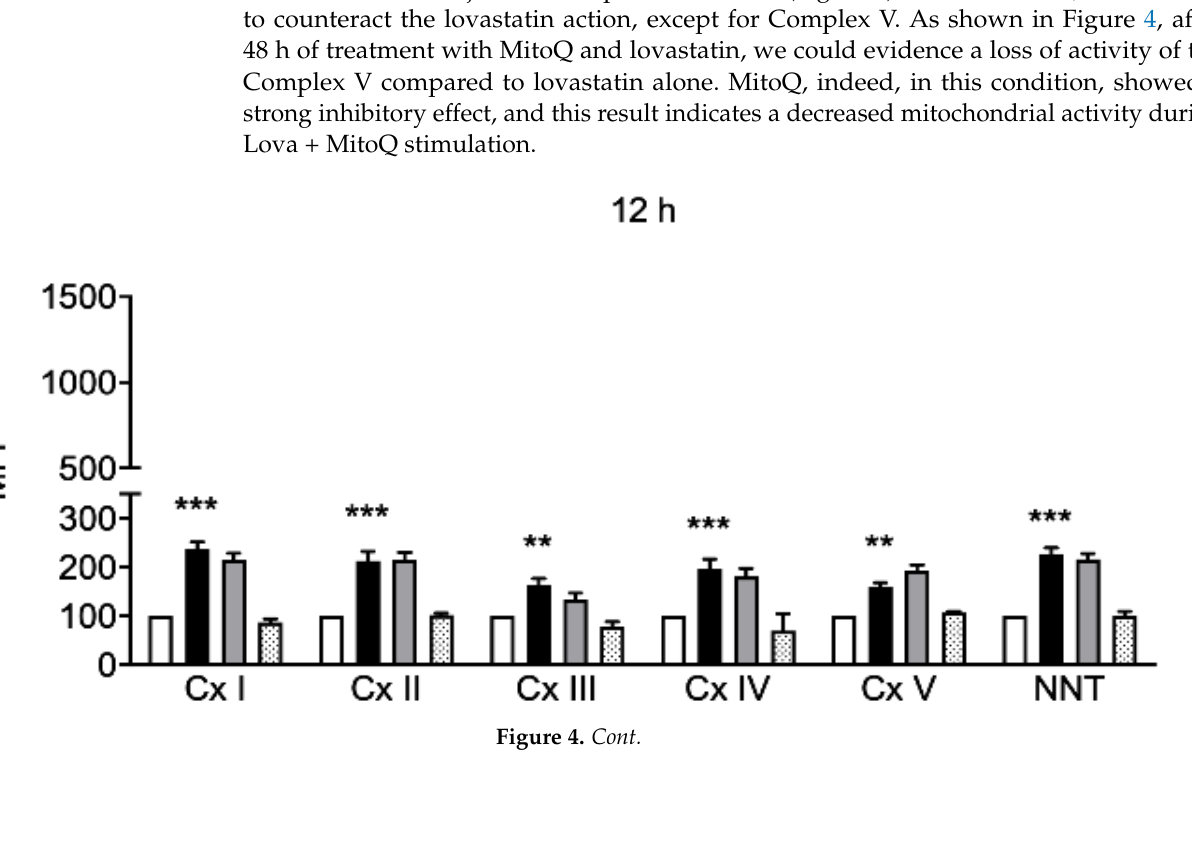
Figure 4. Mitochondrial complexes activity in DAOY cells ( N = 4 independent experiments). For mitochondrial activity measurement, cells were treated with lovastatin and MitoQ for 12/24/48 h and then analyzed with a MILLIPLEX ® human oxidative phosphorylation (OXPHOS) magnetic bead panel. Results are reported as mean ± SD. Statistically significant p - values are shown (two-way ANOVA: Lova vs. Untreated: * p < 0.05; ** p < 0.01; *** p < 0.001; MitoQ + Lova vs. Lova: §§ p < 0.01). Abbreviations: Untr, untreated; Lova, lovastatin; Cx I, NADH-ubiquinone oxidoreductase (Complex I); Cx II, suc- cinate ubiquinone oxidoreductase (Complex II); Cx III, ubiquinone cytochrome c oxidoreductase (Complex III); Cx IV, cytochrome c oxidase (Complex IV); Cx V, ATP synthase (Complex V); NNT, nicotinamide nucleotide transhydrogenase.